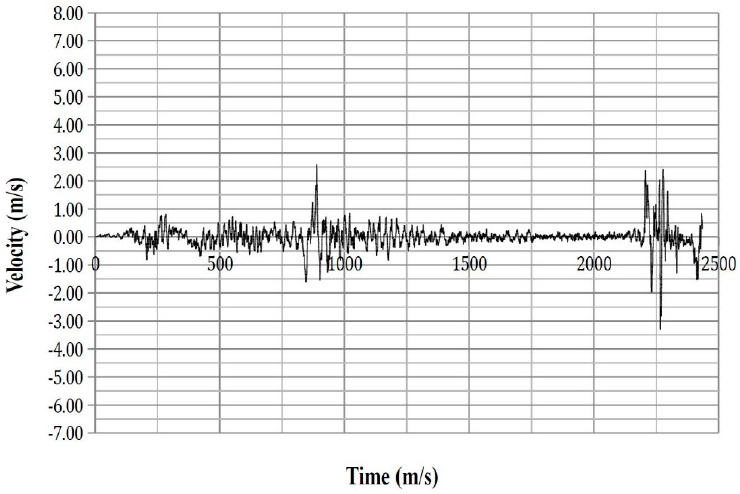
Figure A24. ATD Position 5 y-axis velocity for Node 380870